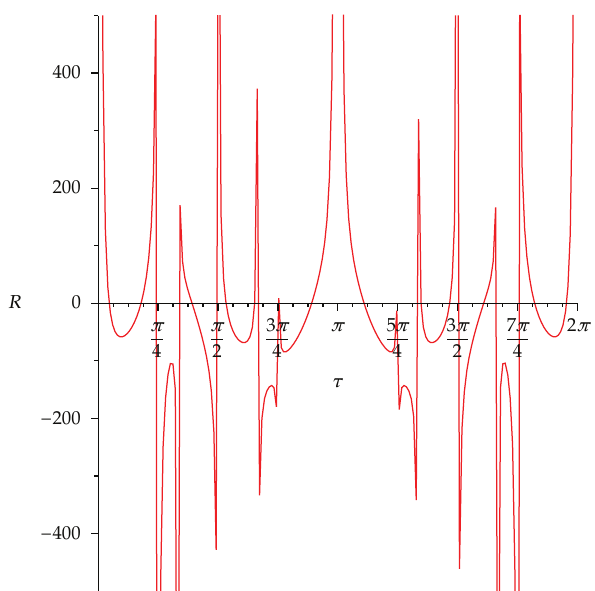
Figure 4: The evolution of the R with respect of the cosmic time τ for (cid:2) 3.7 (cid:3)